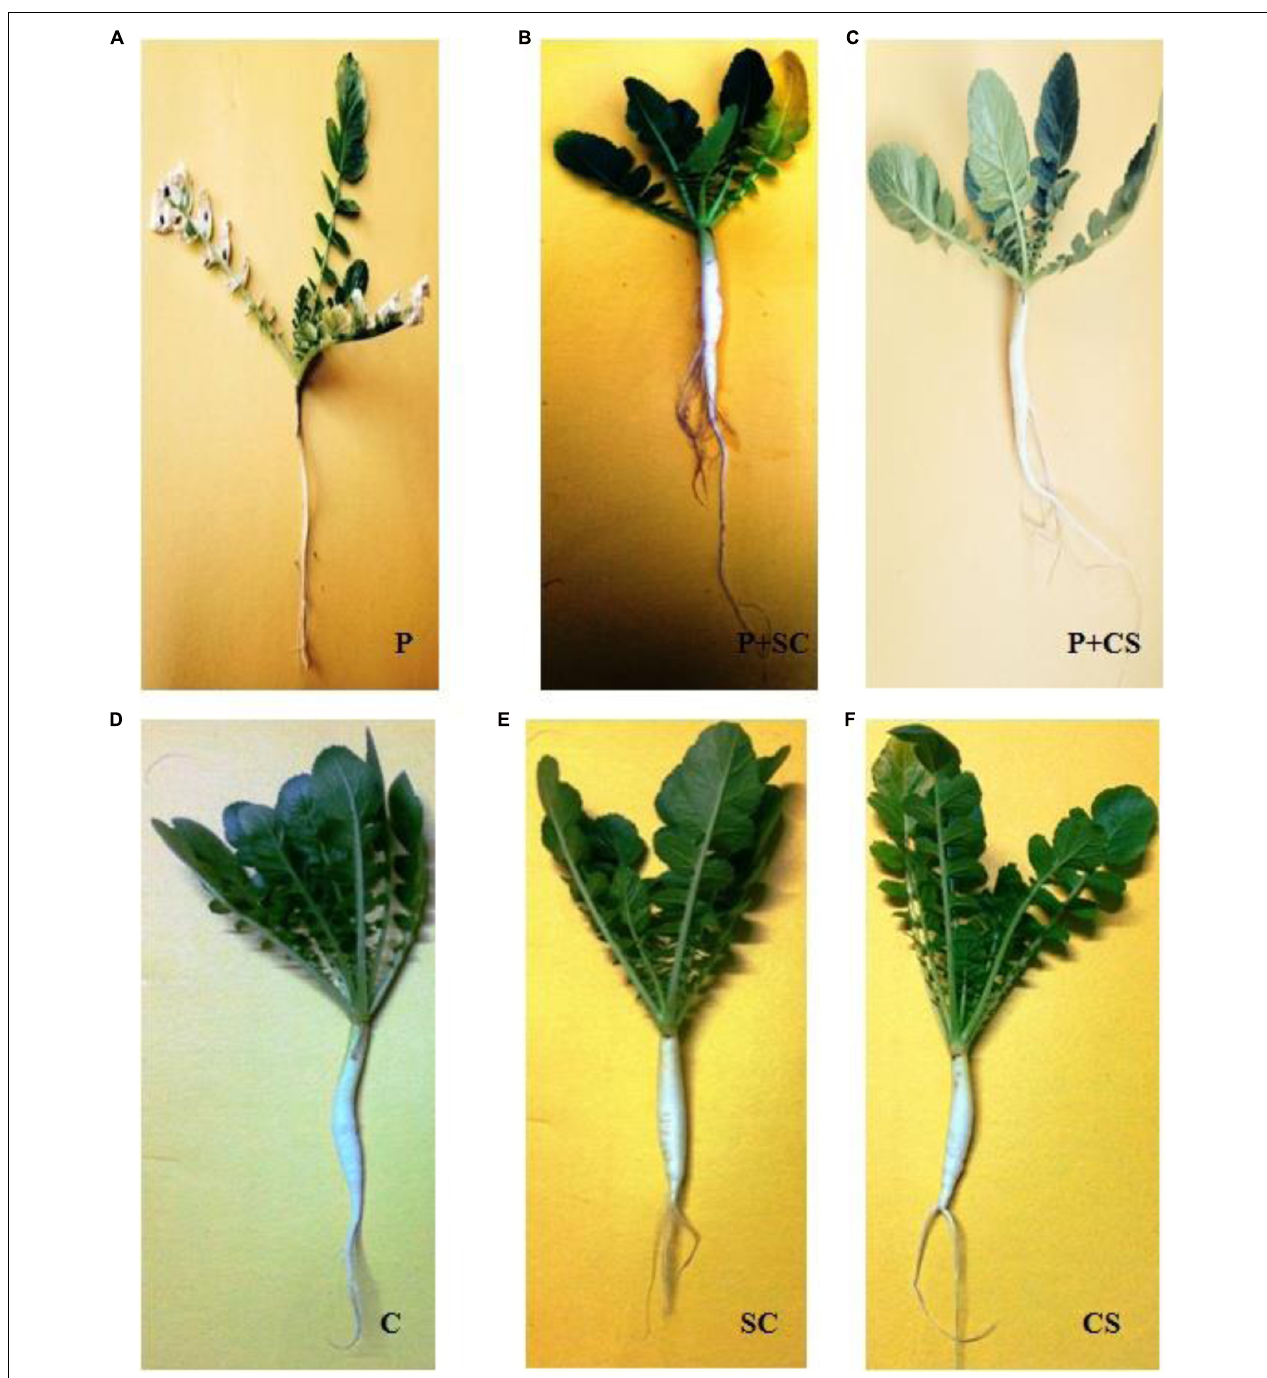
FIGURE 7 | Biocontrol potential of S. hydrogenans DH16 and its culture filtrate as foliar application on A. brassicicola causal agent of leaf spot disease in pot experiments. Radish plants 20 days after inoculation with (A) pathogen (B) pathogen + Streptomyces cells (C) pathogen + Streptomyces extract (D) water only (E) Streptomyces DH16 only (F) Streptomyces extract.